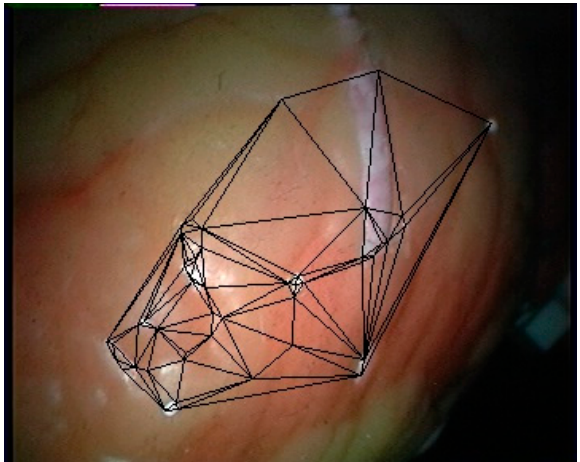
Figure 11. Triangulation results on the left image.